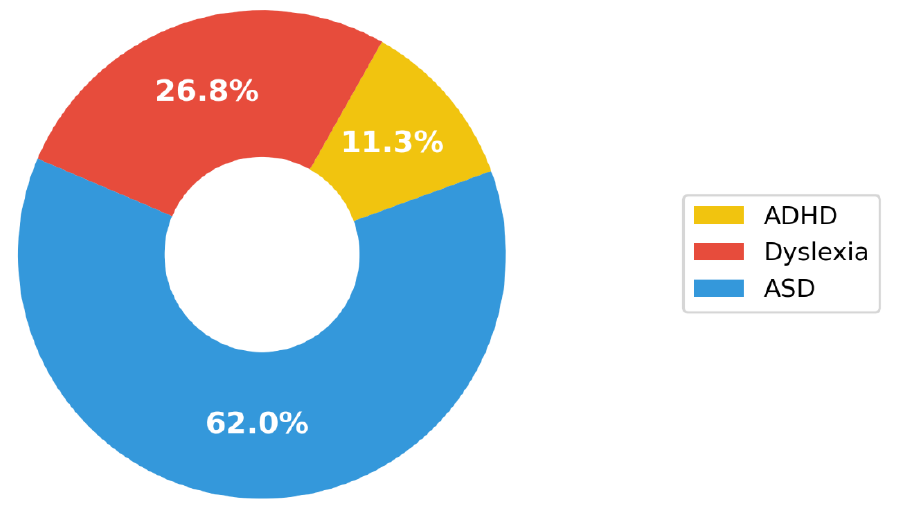
Figure 9. Pie chart representation of assistive tools used to aid in the learning of ADHD, dyslexia and ASD students.